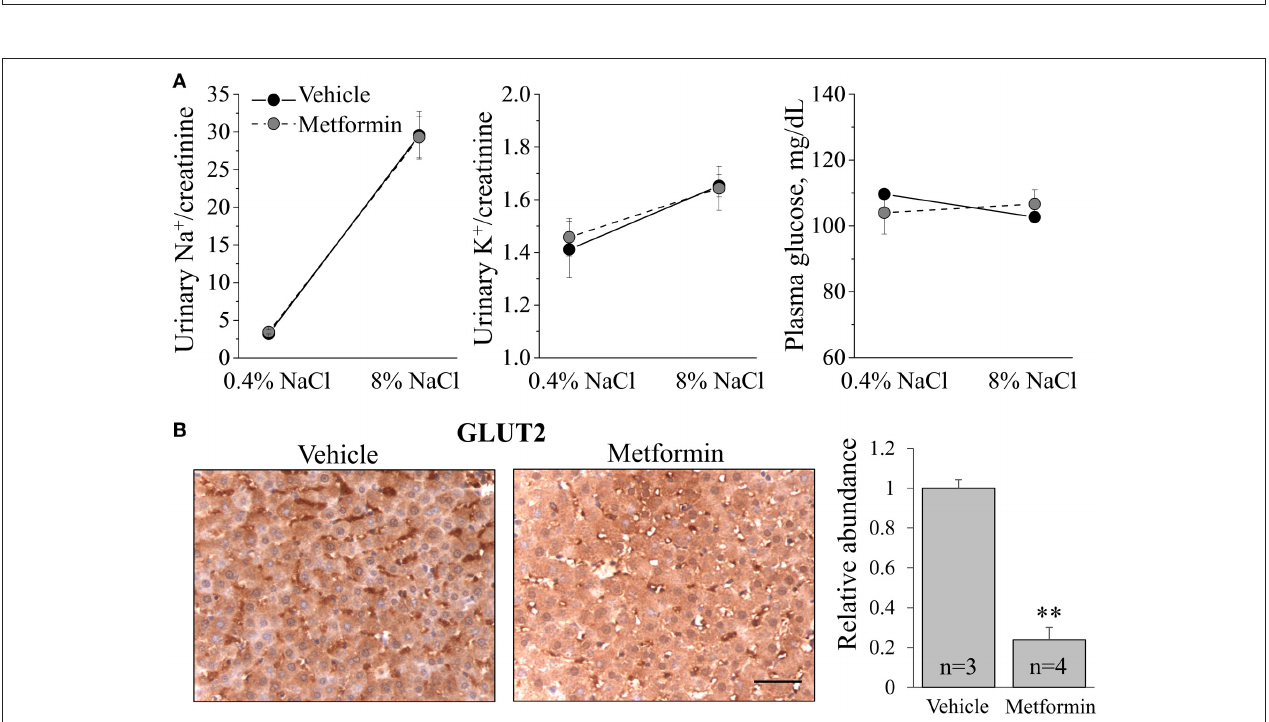
FIGURE 3 | Metformin treatment reduces Glut2 expression in the liver. (A) Urinary sodium and potassium excretion and plasma glucose levels in vehicle- and metformin-treated rats. (B) Immunohistochemical staining demonstrates that metformin treatment decreases abundance of hepatic Glut2, a key glucose transporter involved in glucose release (40x). Scale bar = 50 µ m. Shown on the right is summary graph for Glut2 relative abundance (** p < 0.01 relative to vehicle).